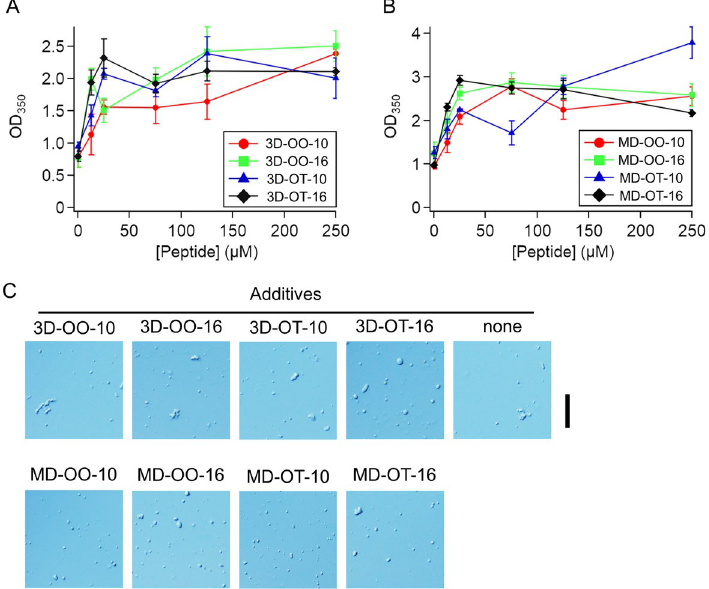
Figure 3. All designed peptides targeting p53 N-terminal IDR promote p53 droplet formation. ( A ) Effect of the 3D structure-based designed peptides targeting the N-terminal IDR as additives on p53 droplet formation detected as OD 350 . ( B ) Effect of the MD-based designed peptides targeting the N-terminal IDR as additives on p53 droplet formation detected as OD 350 . ( C ) DIC images of p53 solutions in the presence and absence of 250 µM designed peptides. “None” denotes the absence of designed peptides as control. Scale bar, 20 µm. In ( A and B ), error bars represent standard error ( N ≥